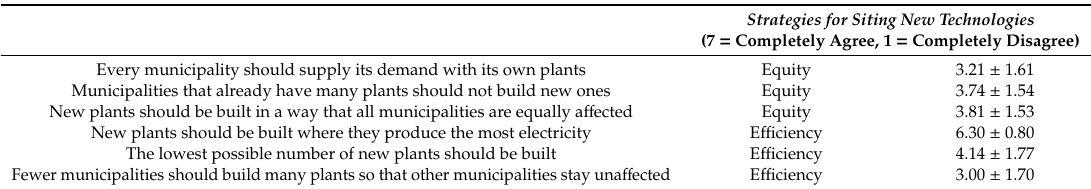
Table 3. Strategies for siting new technologies in terms of e ffi ciency-equity tradeo ff (means ± standard